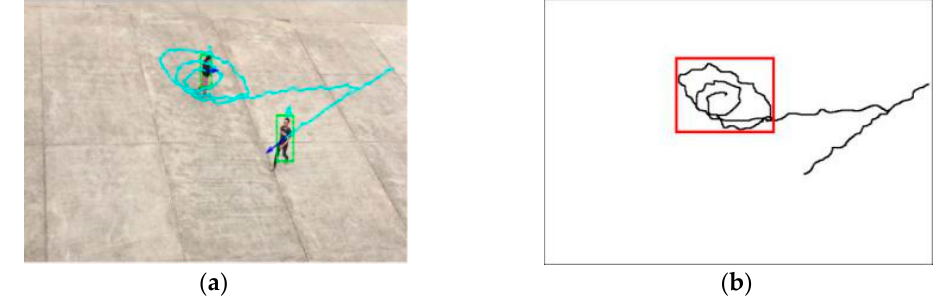
Figure 2. Rectangle loitering. ( a ) A loitering in the real scene. ( b ) The trajectory simulation map corresponding.